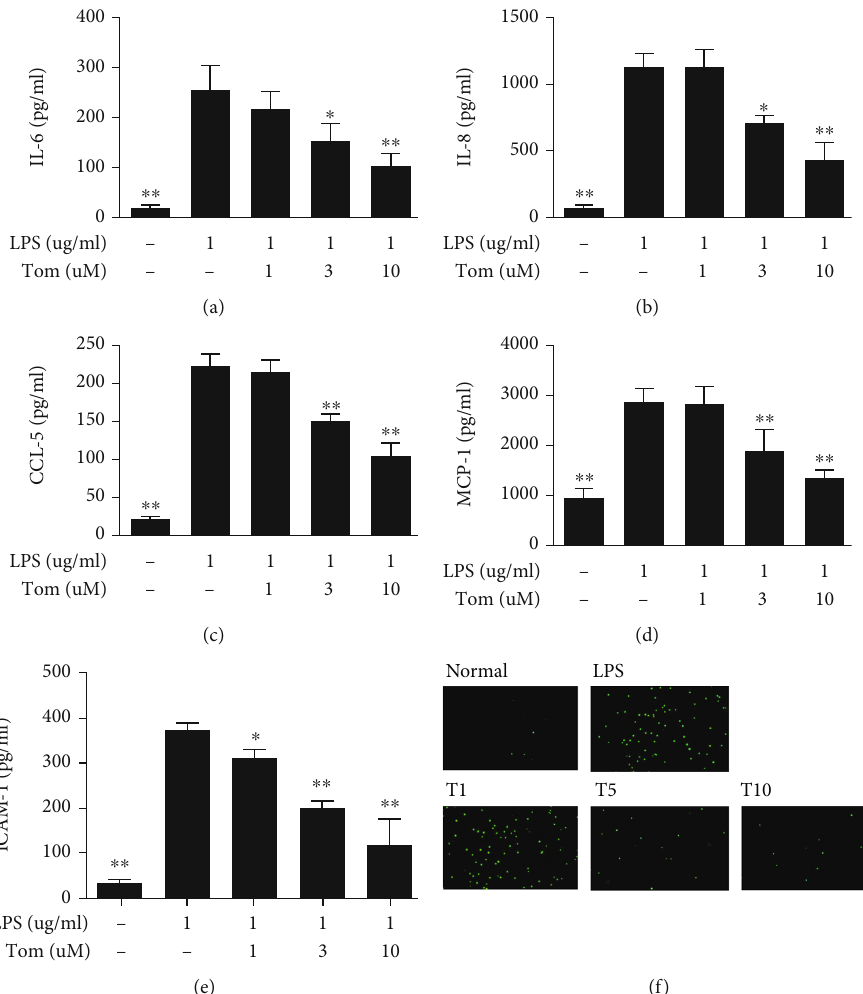
Figure 10: Tomatidine a ff ects in fl ammation in LPS-stimulated A549 cells. Concentration of (a) IL-6, (b) IL-8, (c) CCL5, (d) MCP-1, and (e) ICAM-1 detected by ELISA. (f) Tomatidine (1-10 μ M) inhibited THP-1 monocyte adherence to active A549 cells. Data are presented as the mean ± SEM . ∗ p < 0 : 05 and ∗∗ p < 0 : 01 vs. LPS